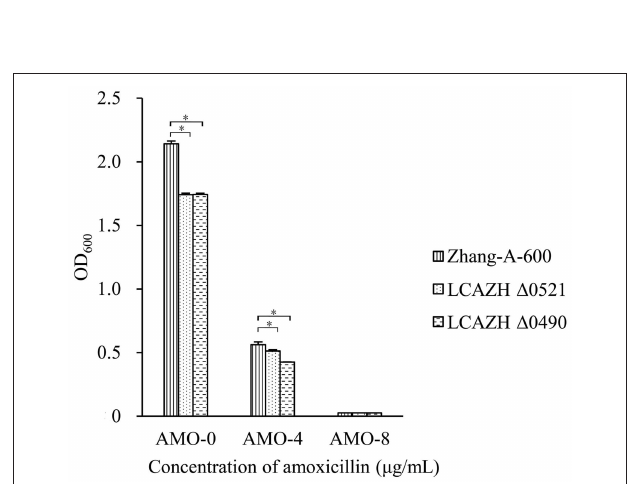
FIGURE 2 | Effect of amoxicillin concentration on the OD 600 of the culture medium of the wild-type (Zhang-A-600) and the mutants (LCAZH 1 0490 and LCAZH 1 0521). Error bars represent standard deviation. Asterisks indicate the level of statistical significance (“*” represents P < 0.05); no asterisk indicates no significance ( P >